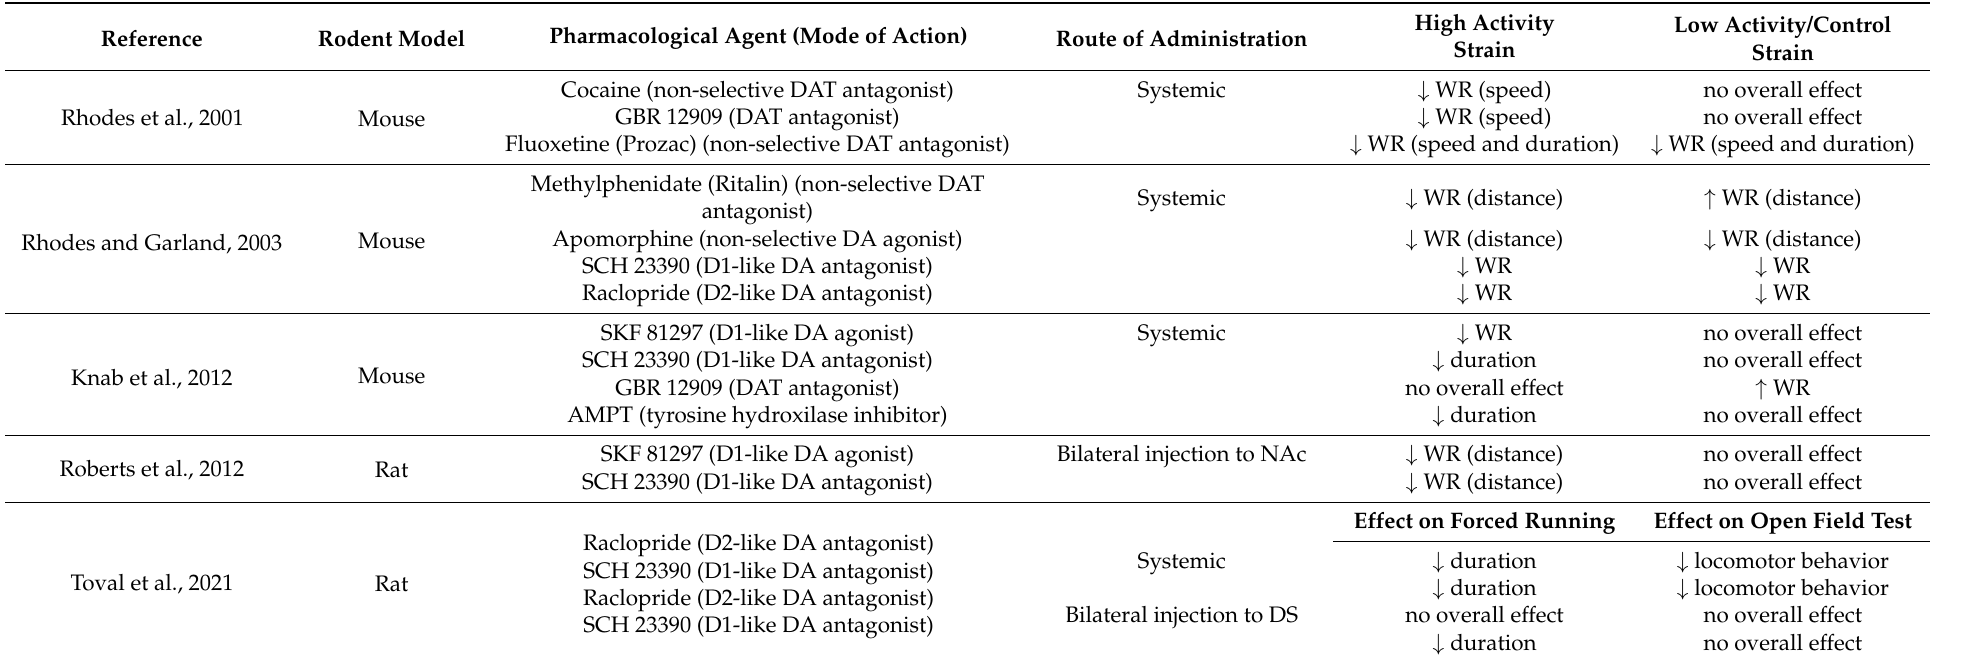
Table 1. Experimentally employed pharmacological agents targeting dopaminergic pathways and physical